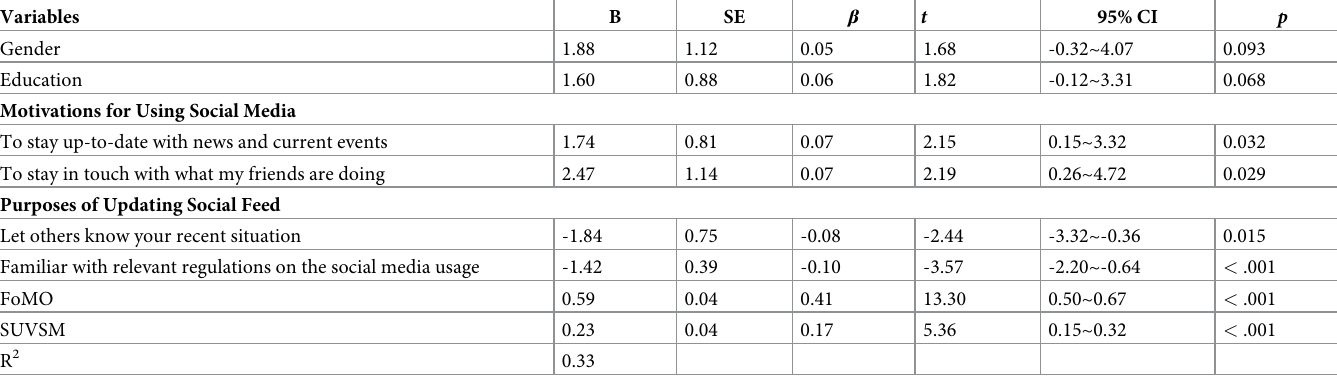
Table 1. Determinants of SMF among nursing students (n =